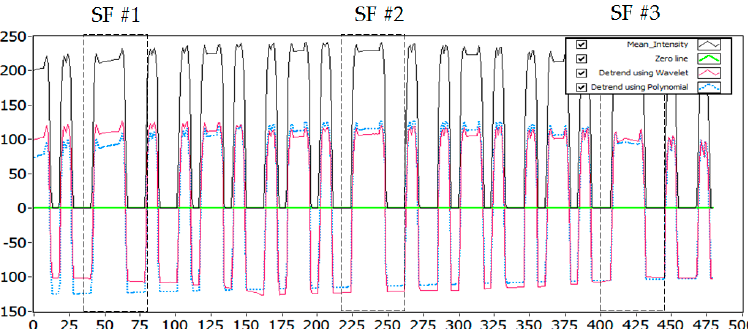
Figure 6. An experimental result of oversampled packet in within a rolling image. SF #1, SF #2, and SF #3 are Start Frame of three data sub-packets (three DS). #3 are Start Frame of three data sub-packets (three